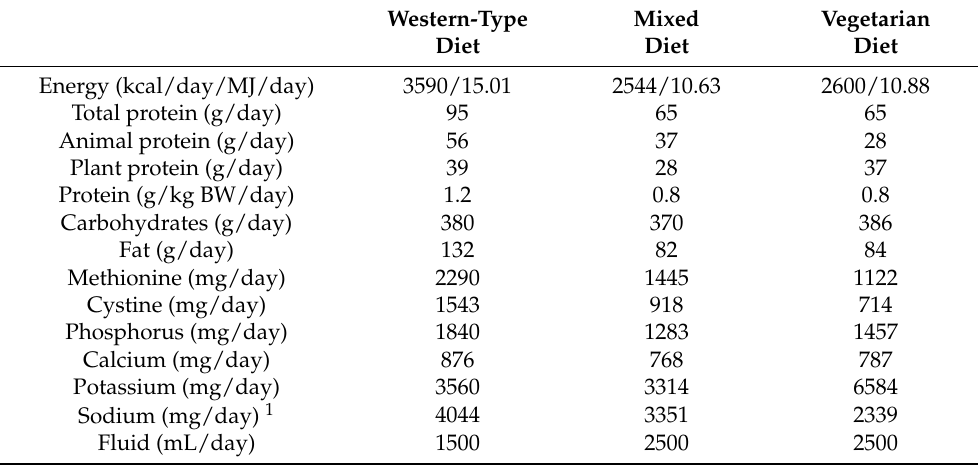
Table 1. Composition of the standardized Western-type, balanced mixed, and lacto-ovo- vegetarian